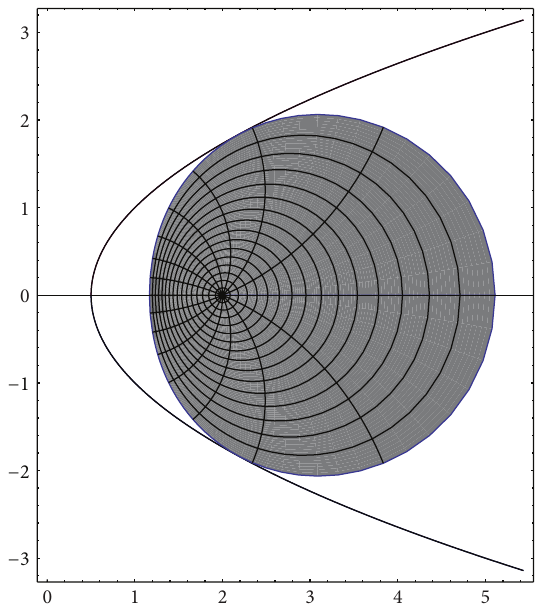
Figure 9: Image of |𝑧| ≤ 0.44915 touches |𝑤 − 1| = Re 𝑤